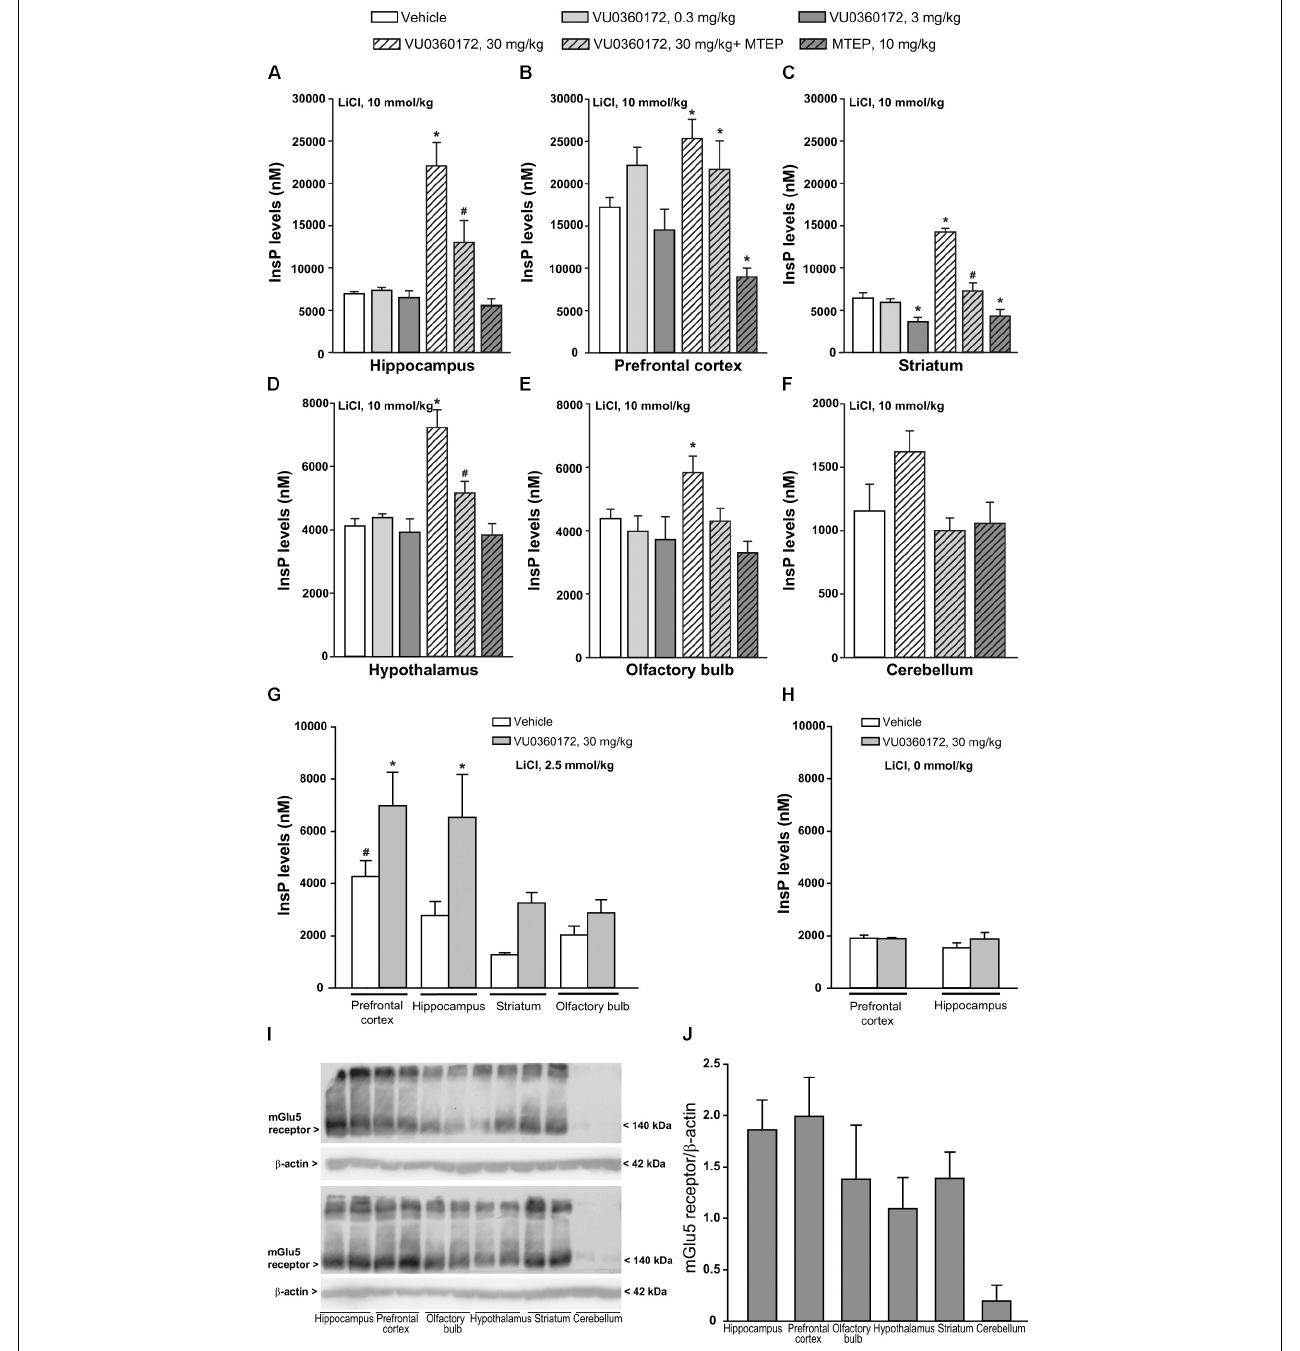
FIGURE 1 | Measurements of endogenous InsP levels in CD1 mice treated with lithium ions and then challenged with the selective mGlu5 receptor PAM VU0360172. (A–F) InsP levels in selected brain regions of adult CD1 mice treated i.p. with 10 mmol/kg of lithium chloride (LiCl) followed by vehicle, VU0360172 (0.3, 3, or 30 mg/kg), MTEP (10 mg/kg), or VU0360172 (30 mg/kg) + MTEP. Values are means + SEM of 5–12 mice per group. P < 0.05 vs. values obtained in mice treated with vehicle in the same brain region ( ∗ ) or vs. values obtained in mice treated with 30 mg/kg VU0360172 in the absence of MTEP (#) (One-way ANOVA + Fisher’s LSD; F ( 5 , 38 ) = 19.82 for hippocampus; F ( 5 , 38 ) = 7.33 for prefrontal cortex; F ( 5 , 38 ) = 27.47 for striatum; F ( 5 , 35 ) = 12.28 for hypothalamus; F ( 5 , 35 ) = 3.28 for olfactory bulb). (G) InsP levels in selected brain regions of adult CD1 mice treated i.p. with 2.5 mmol/kg of LiCl followed by vehicle or VU0360172 (30 mg/kg). Values are means + SEM of 5–7 mice per group. p < 0.05 vs. values obtained in mice treated with vehicle in the same brain region ( ∗ ) or vs. values in the striatum or olfactory bulb of mice treated with vehicle (#) [One-Way ANOVA + Fisher’s LSD; F ( 7 , 26 ) = 6.3]. (H) InsP levels in the prefrontal cortex and hippocampus of adult CD1 mice injected with VU0360172 (30 mg/kg) or its vehicle without pretreatment with LiCl. Values are means + SEM of 3-4 mice per group. (I,J) Western blot analysis of mGlu5 receptors in four CD1 mice randomly selected from the same groups as in (A–F) . Densitometric values are means + SEM.